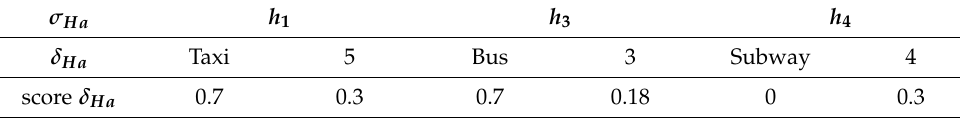
Table 10. Scores for the sub-sequence σ Ha .